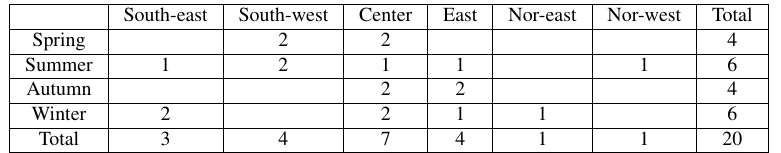
Table 2: Counting measure with the hierarchies of date in seasons and of town in